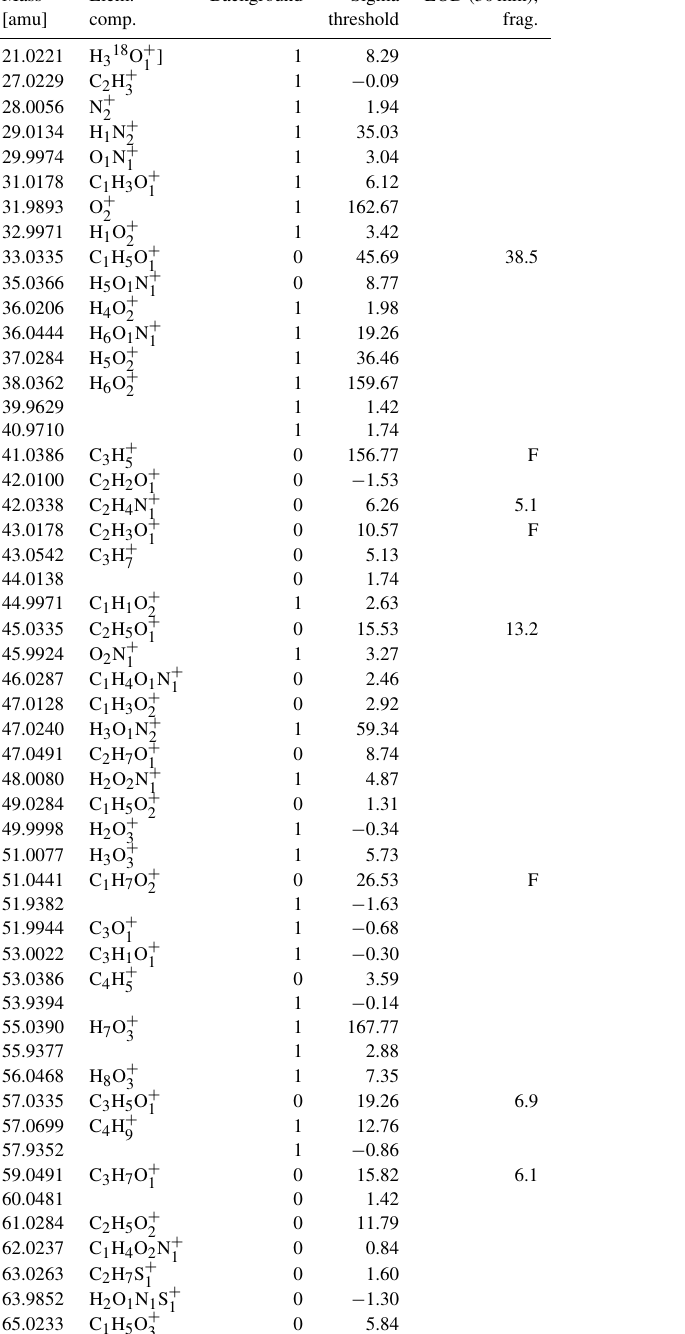
Table A1. Information about all 164 measured mass peaks in Bosco Fontana. The limit of detection is given for the calibrated masses. Masses with an F in the last column are filtered out as they were identified as fragments or